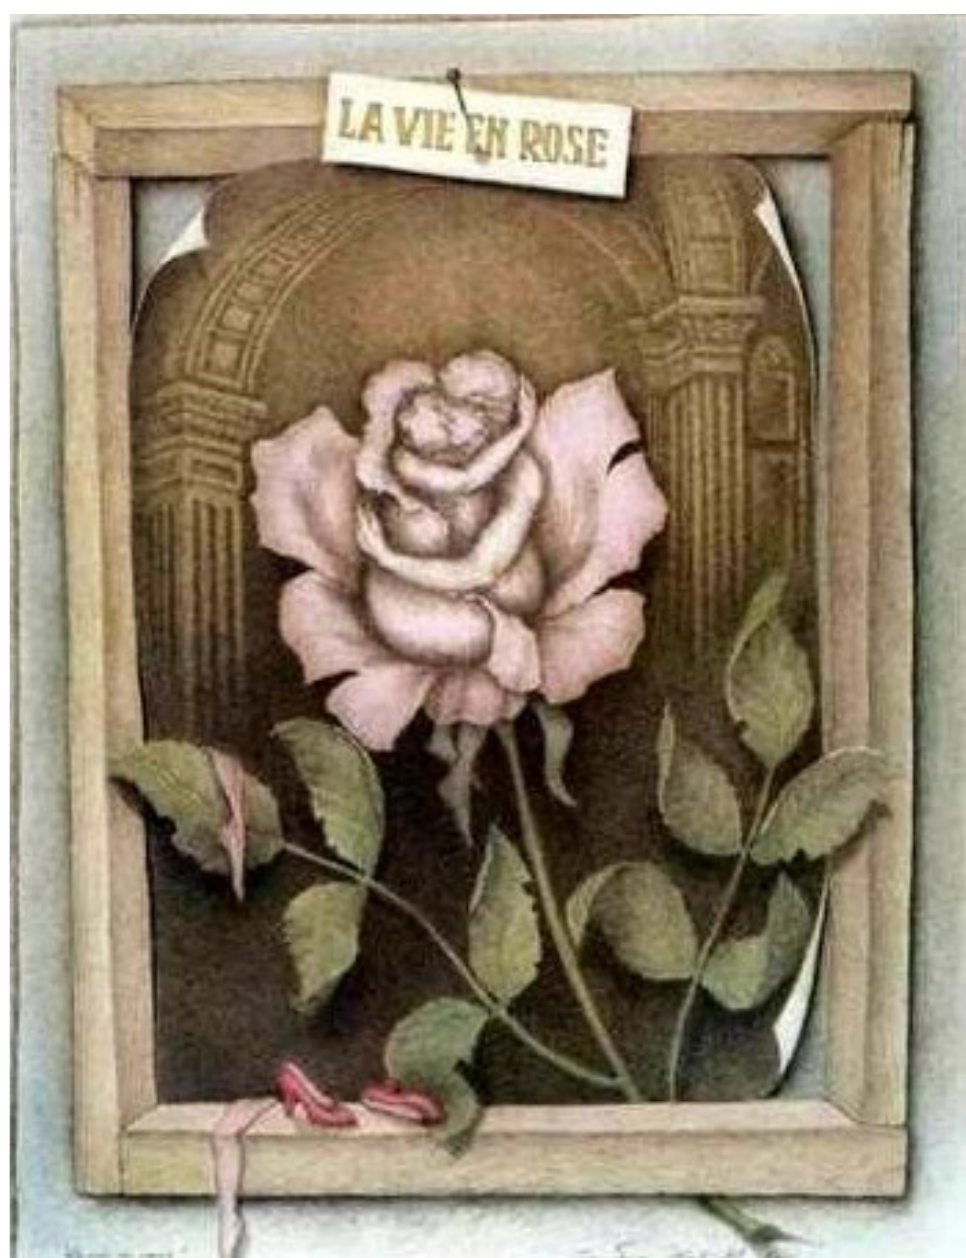
Figure 8. Rose, legs, couple, and shoes.